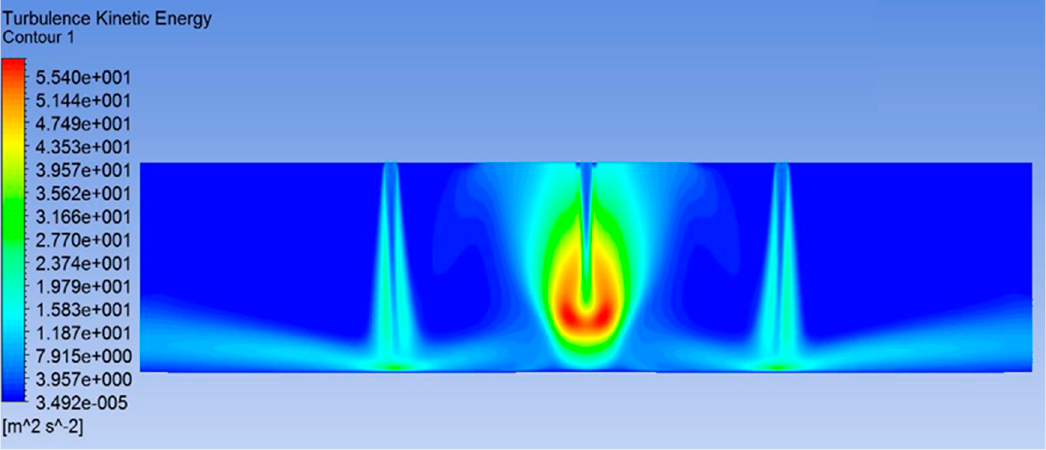
Figure 17. Turbulent kinetic energy contours of three slot jets configuration with H/B = 16, Re = 5500 and realizable k- ε .